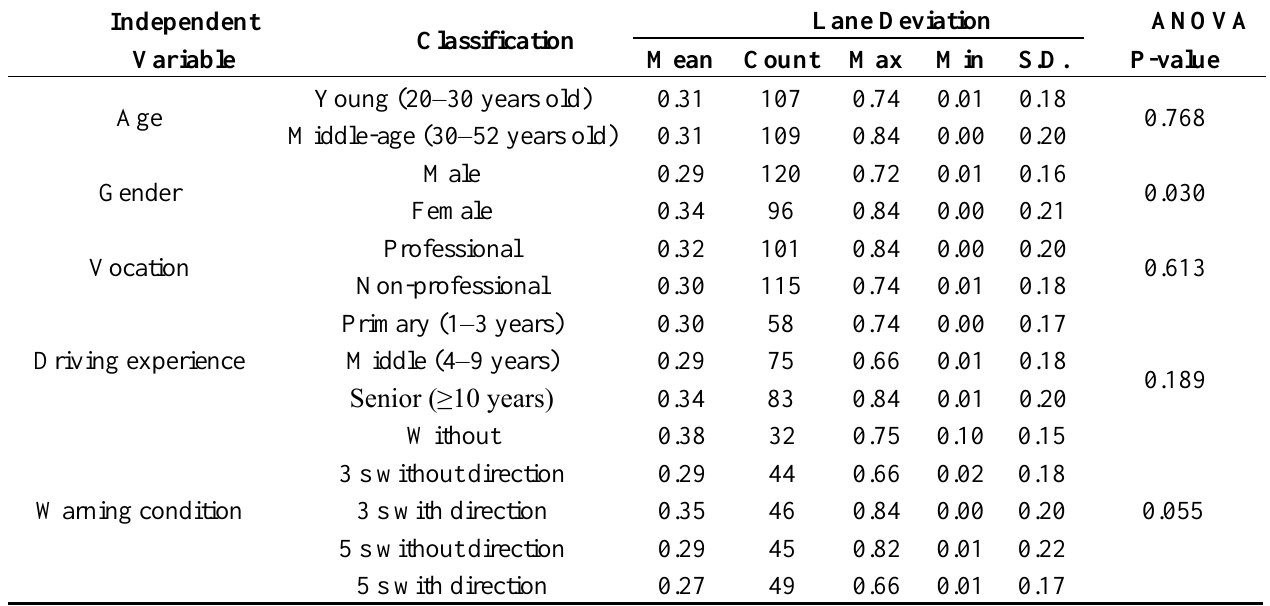
Table 8. Descriptive statistics of lane deviation characteristics and ANOVA